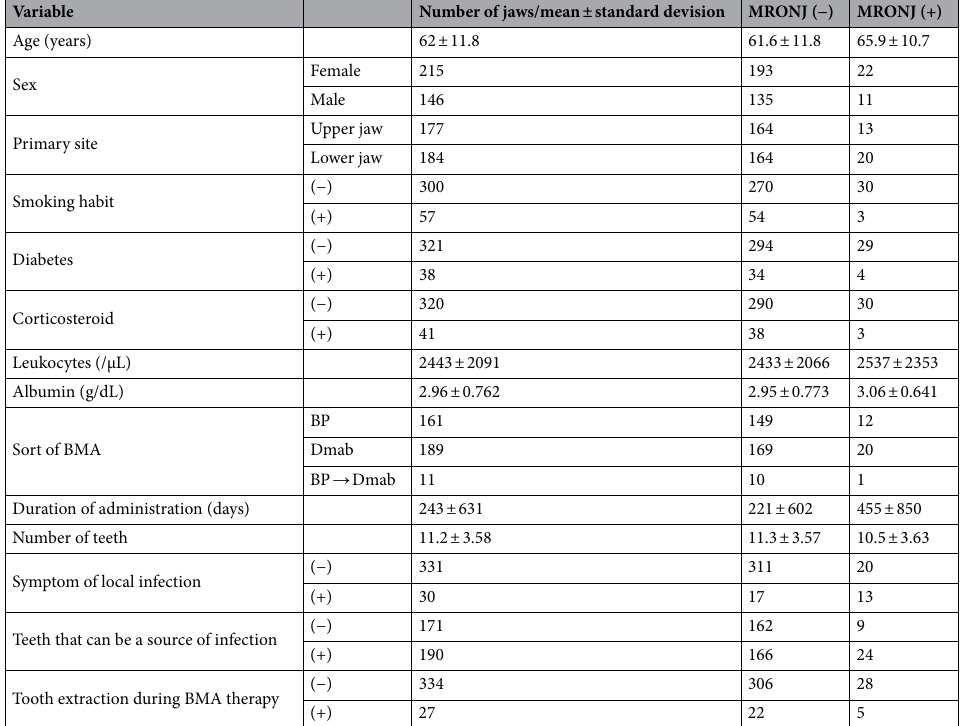
Table 1. Patient characteristics (per jaw). Teeth that can be a source of infection: periapical lesion (> 3 mm) or alveolar bone loss (> 1/2) or probing pocket depth (> 4